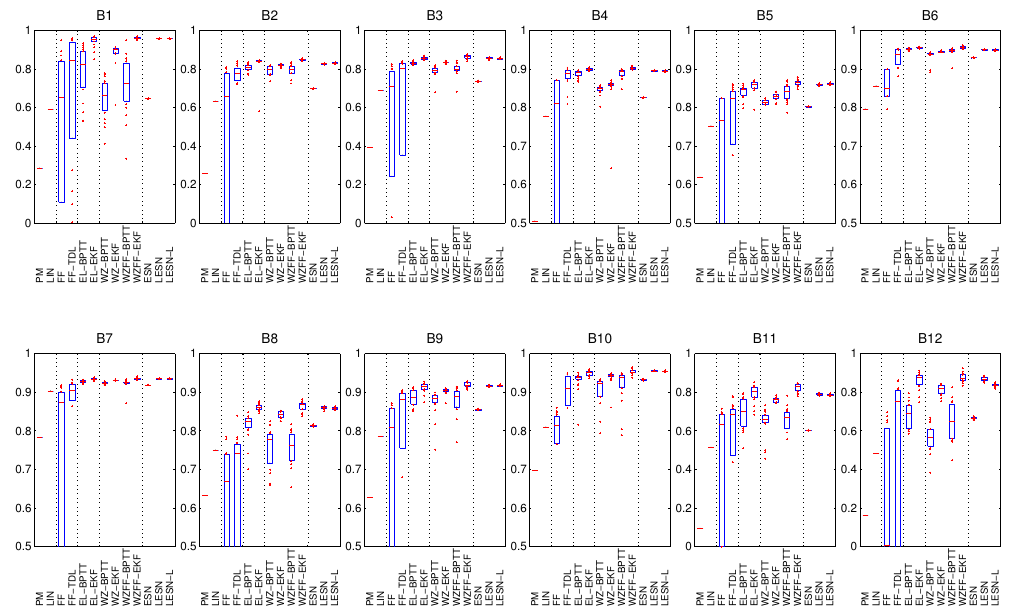
Fig. 4. Training performance in terms of CE. The box plot expresses statistics of over 20 models runs. The central mark is the median, the edges of the box are the first and third quartiles, and points outside that range are plotted individually as dots. Note that not all subfigures have the same